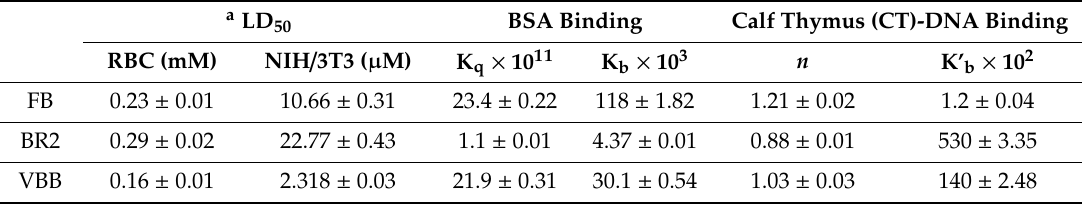
Table 1. The lethal dose 50% (LD 50 ) values on RBC and NIH / 3T3 cells as well as the bovine serum albumin (BSA) and DNA-binding parameters of the hair dyes.